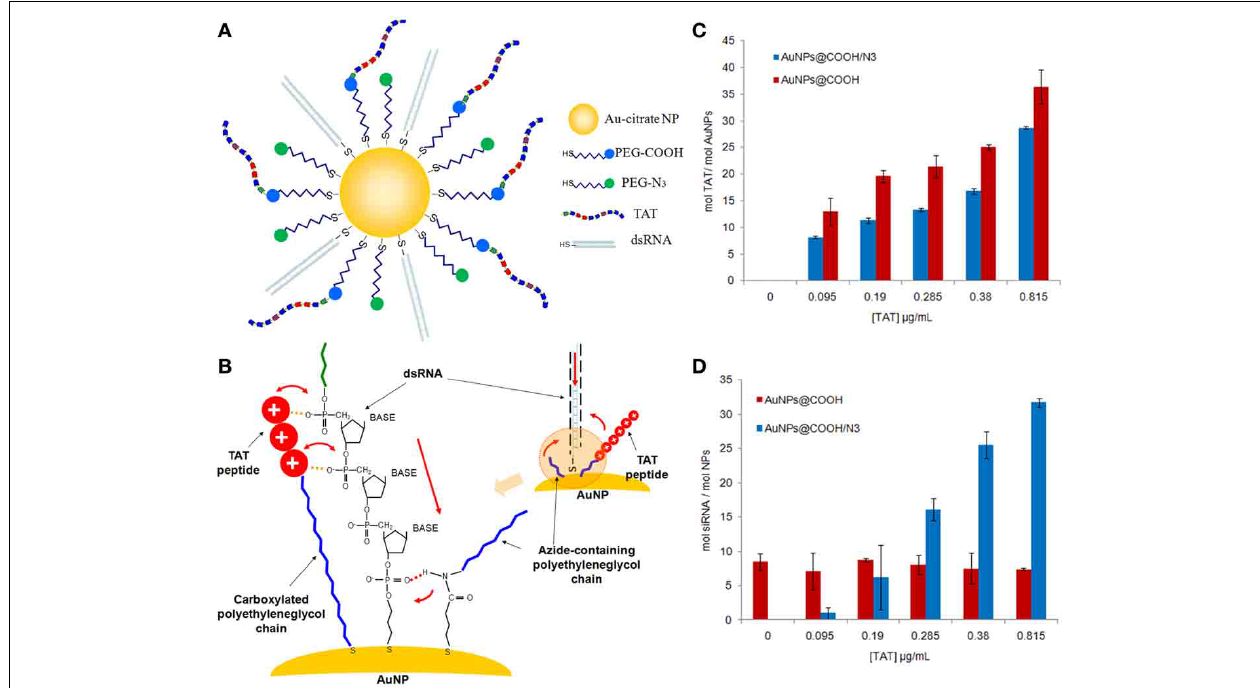
FIGURE 2 | Polyvalent PEGylated gold nanoparticles. (A) Bioconjugation of the surface-modified gold nanoparticles with different thiol-PEG layer composition (SH-EG(7)-CH 2 -COOH and SH-(CH 2 ) 3 -CONH-EG(6)-CH 2 -N 3 ), TAT peptide and thiol-dsRNA oligonucleotide. (B) Mechanism for the enhancement of the dsRNA loading on AuNPs functionalized with PEG chains and TAT peptide. The azide group has a resonant structure with a positively polarized behavior that can attach the negatively charged thiolated oligonucleotide to the gold surface. The azide-containing chain also encloses an amide group near the gold surface that could play a role in approaching the thiol group of the oligonucleotide to the gold